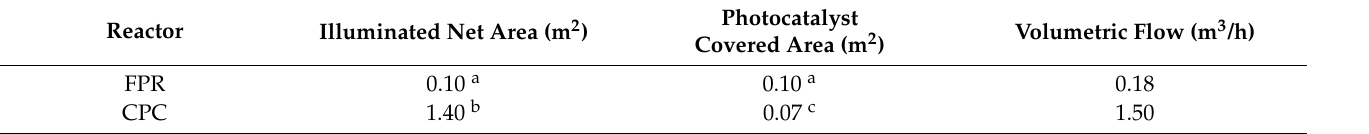
Figure 2. FPR reactor scheme. Table 1. Operational parameters differing between reactors.